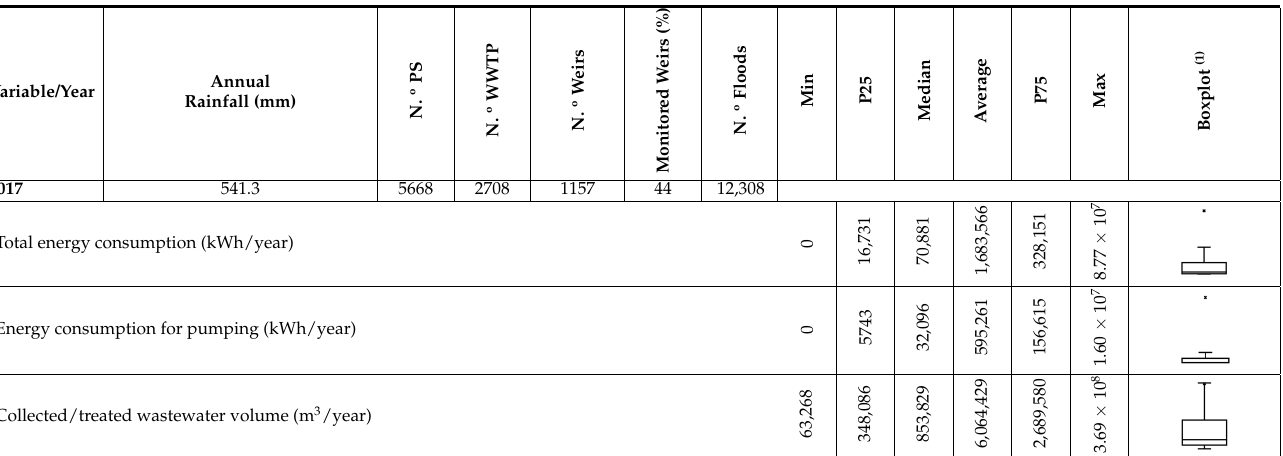
Table A4. National characterization for the evaluation of the W-E-G nexus for 2017.